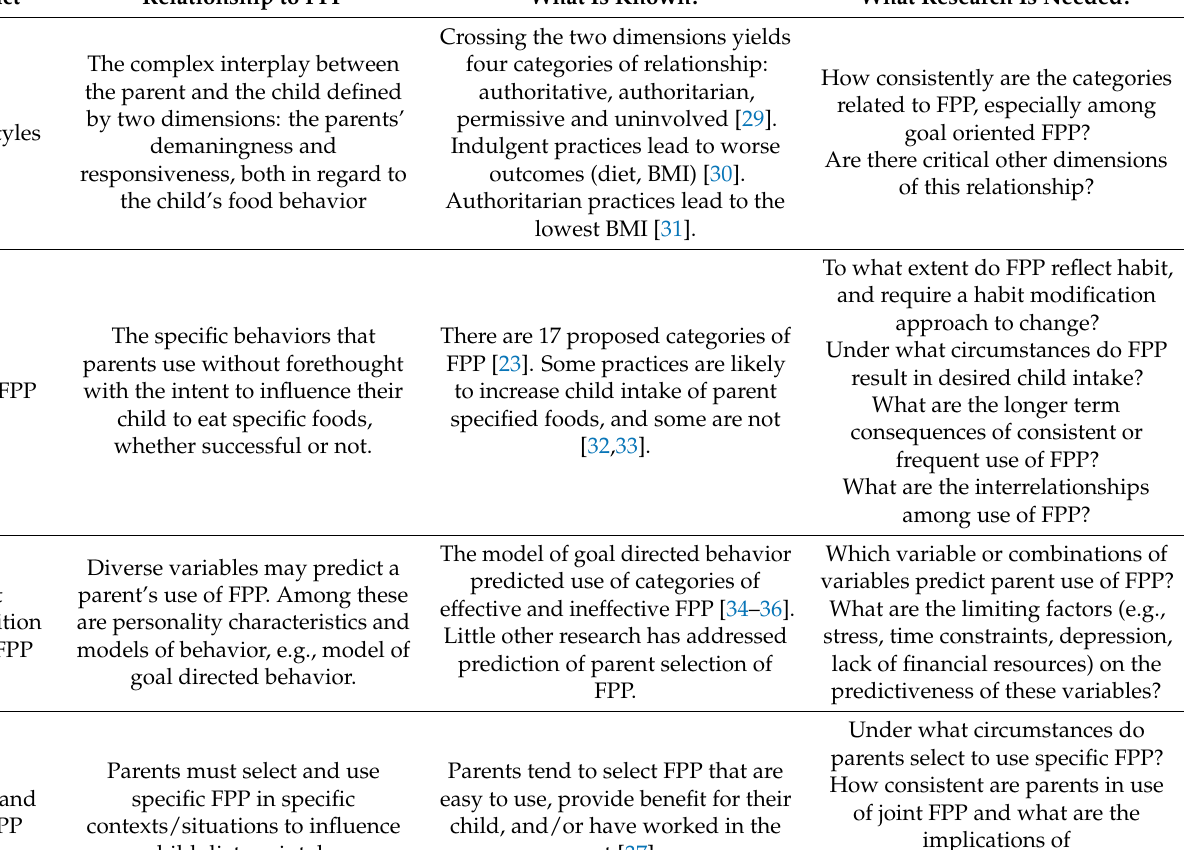
Table 1. Constructs, their relationship to precision food parenting, what is known, and priority research needs.